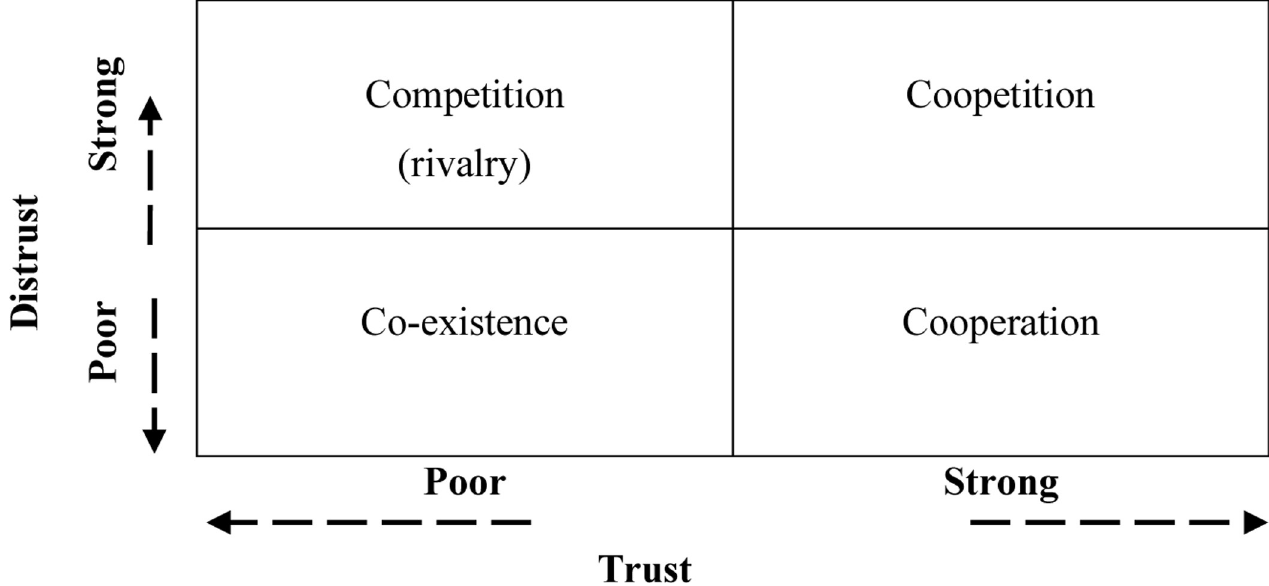
Fig 1. Relations between trust and distrust by nature of interorganisational